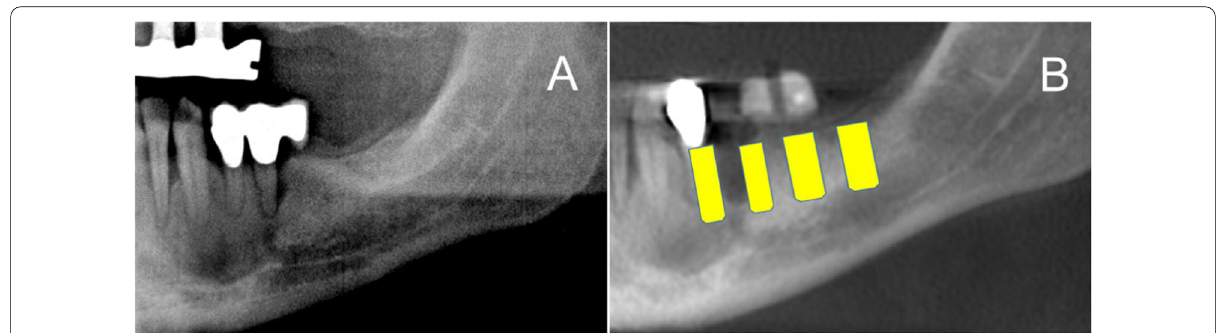
Fig. 1 A Initial panoramic radiography of the left mandible; B the determination of the planned implants in regions 34–37 using an orientation template